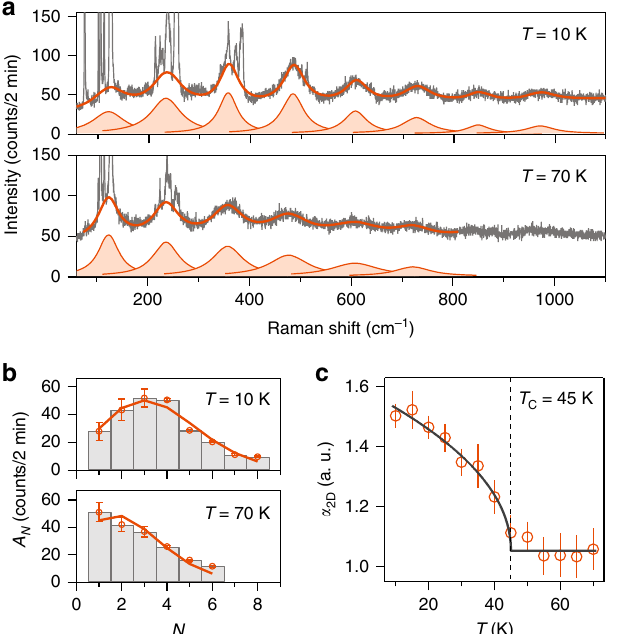
Fig. 3 Enhanced e-ph coupling across the magnetic onset T C in bilayer CrI 3 . a Raman spectra of bilayer CrI 3 acquired at 10 K and 70 K, respectively. Solid orange lines are fi ts to the raw Raman spectra, using a sum of N Lorentzian pro fi les and a constant background, i.e., (cid:4) (cid:5) P 2 A N Γ N (cid:4) (cid:5) þ C . b Histogram plot of the fi tted Lorentzian mode 2 N 2 ω (cid:2) ω N ð Þ 2 þ Γ N 2 intensity ( A N ) as a function of order index ( N ) at 10 K and 70 K. Solid curves are fi ts of the peak intensity pro fi les to the Poisson distribution e (cid:2) α α N function, A N ¼ A Fig. 4 Evolution of polaronic effect across the magnetic phase transition N ! . Error bars represent one standard deviation that 0 convolutes the standard errors from the fi ttings to the local individual and from the layered AFM to FM in bilayer CrI 3 . a Raman spectra of bilayer CrI 3 acquired at 10 K in the circularly parallel polarization channels, RR and global multiple Lorentzian pro fi les. c Plot of two-dimensional electron – phonon coupling constant ( α 2D ) as a function of temperature. The LL, where RR (LL) stands for that both incident and scattered polarizations are selected to be right-handed (left-handed) circularly polarized, with an dashed vertical line marks the magnetic onset T C = 45 K, and the solid line ffiffiffiffiffiffiffiffiffiffiffiffiffiffi p A T (cid:2) T applied out-of-plane magnetic fi eld ( B ? ) of 1 T (top), 0 T (middle), and − 1 T C is the fi t to the functional form α 2D T ð Þ ¼ (bottom), respectively. b , c Plots of the Poisson fi t amplitude A electron – phonon coupling strength α 2D ( c ) as a function of the applied B ? in bars in c represent one standard error in the Poisson fi RR (orange data points) and LL (blue) channels. Solid lines are step (orange and blue in b ) and linear (gray in c ) function fi ts to the magnetic fi eld dependence of A and α , respectively. Error bars are de fi ned as one 0 2D standard error of the fi tting parameters.